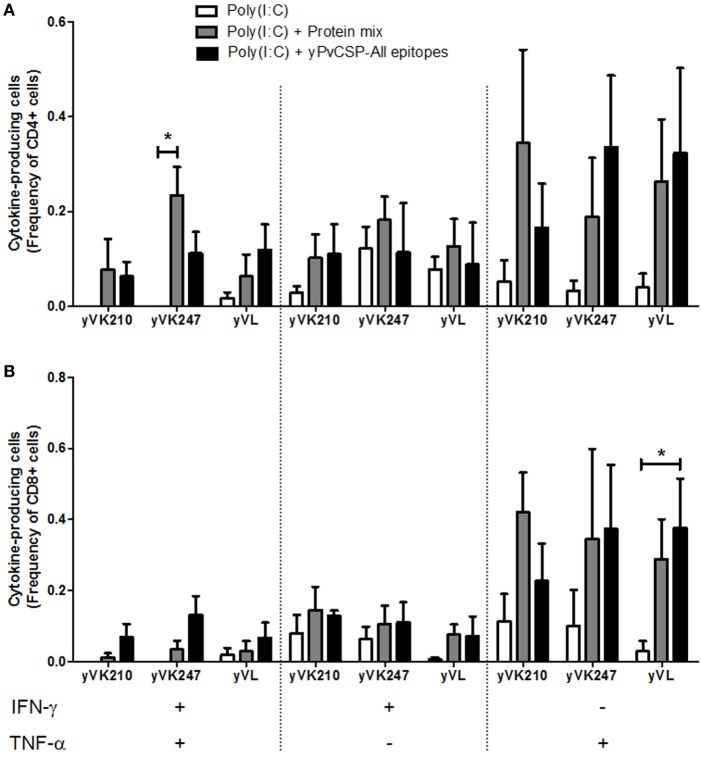
CD4+ and CD8+ T cell-mediated immunity of mice immunized with recombinant proteins. C57BL/6 mice were immunized s.c. with the recombinant proteins following the scheme described in Figure 6A. To determine the intracellular expression of interferon gamma (IFN-γ) and tumor necrosis factor alpha (TNF-α), intracellular cytokine staining (ICS) was performed following the in vitro culture of splenocytes in the presence or absence of the antigenic stimuli yPvCSP-VK210 (yVK210), yPvCSP-VK247 (yVK247), and yPvCSP-P. vivax-like (yVL). (A) Frequency of CD4+ cytokine-producing cells. (B) Frequency of CD8+ cytokine-producing cells. Asterisks denote statistically significant (P < 0.05) higher frequencies of cells from mice immunized with the recombinant proteins when compared to cells from mice injected with adjuvant only. Media backgrounds of all samples were subtracted before plotting.